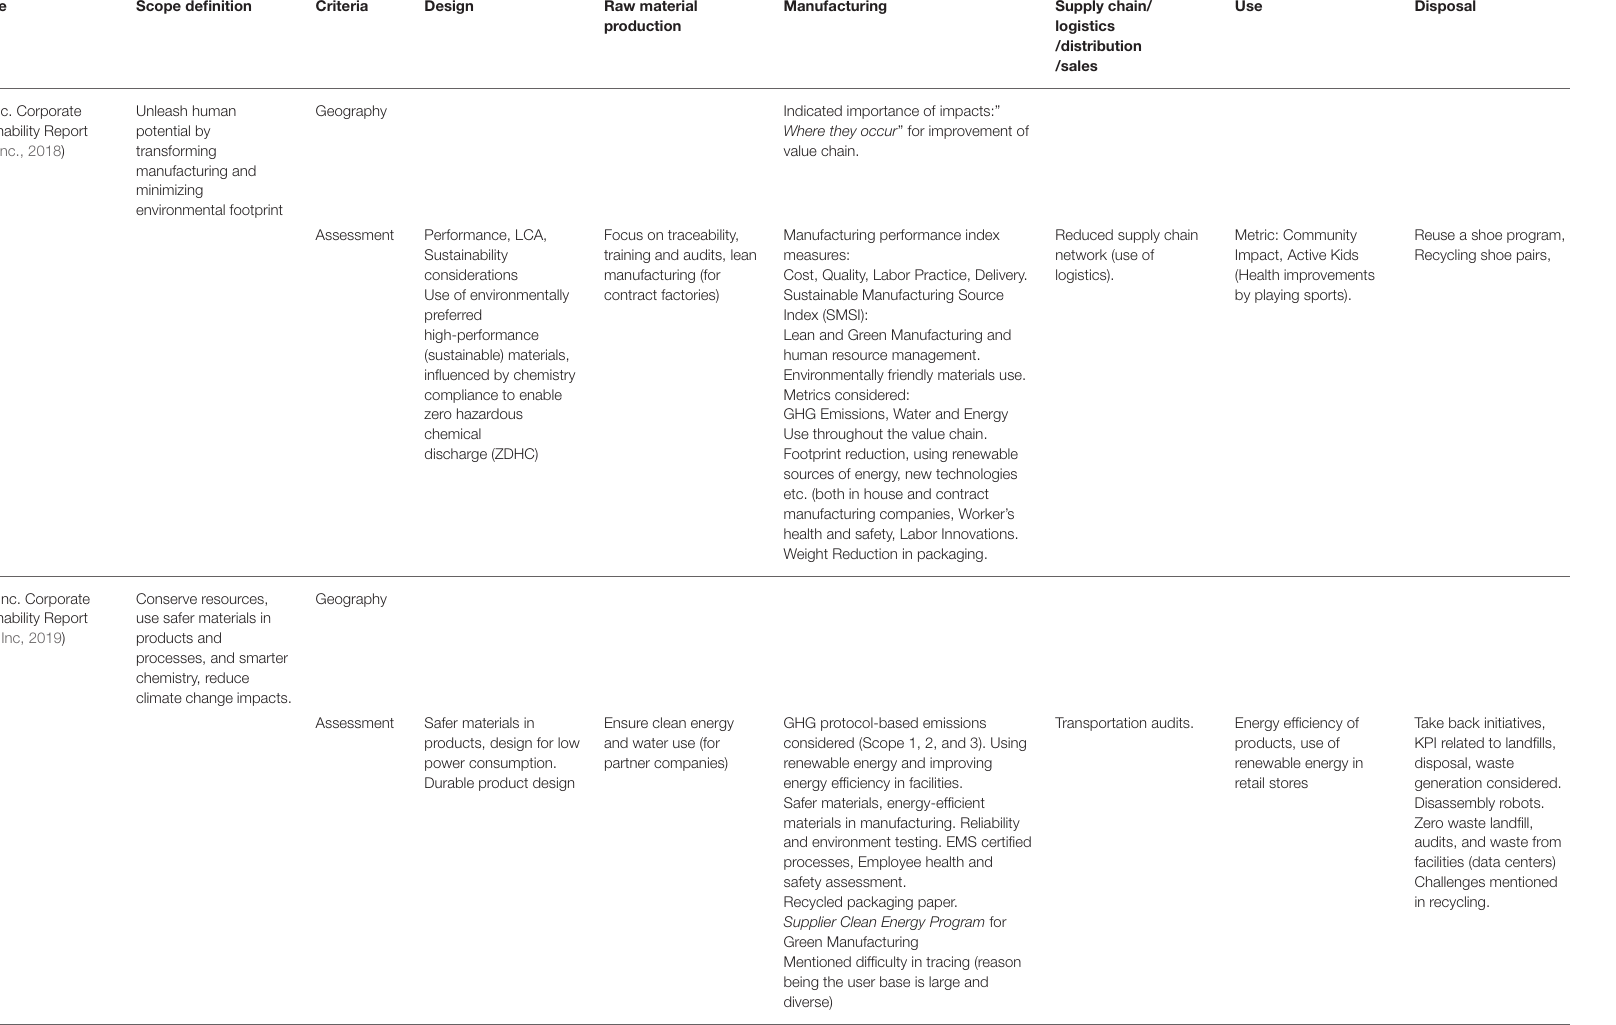
TABLE 4 | Sustainability assessment in industry: criteria for reporting.